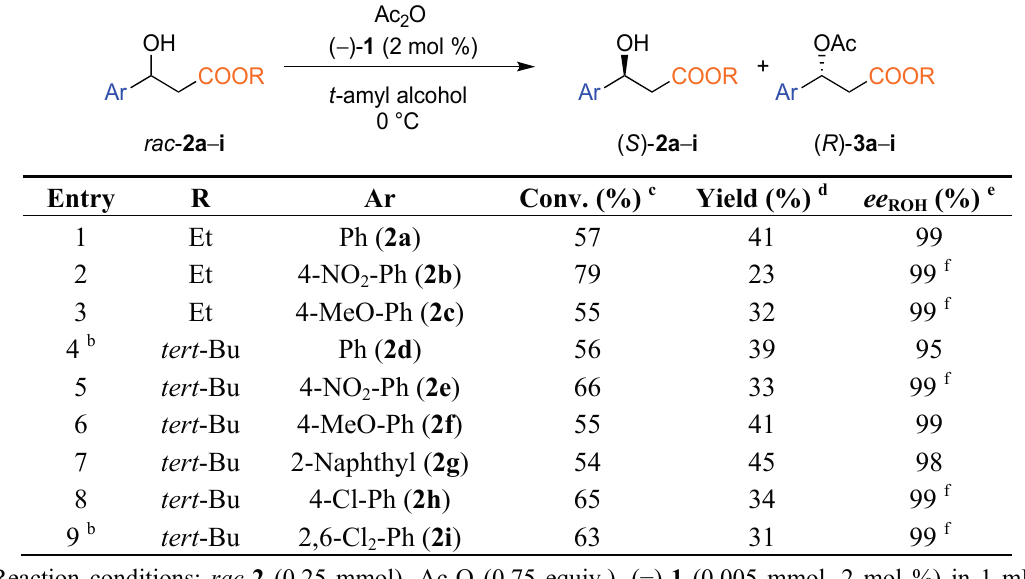
Table 2. Substrate screening for the kinetic resolution of β -hydroxy - β -aryl esters ( rac -2) by ( − )-1 a